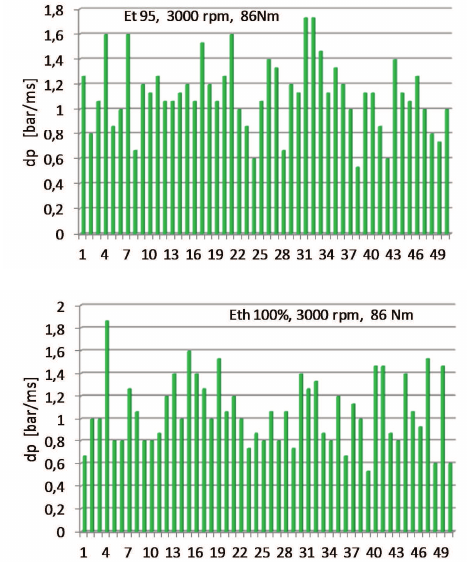
Fig. 7. Comparison of pressure growth rate during combustion on the Fiat 1100 MPI engine fueled with Et 95 gasoline and Eth 100% ethanol